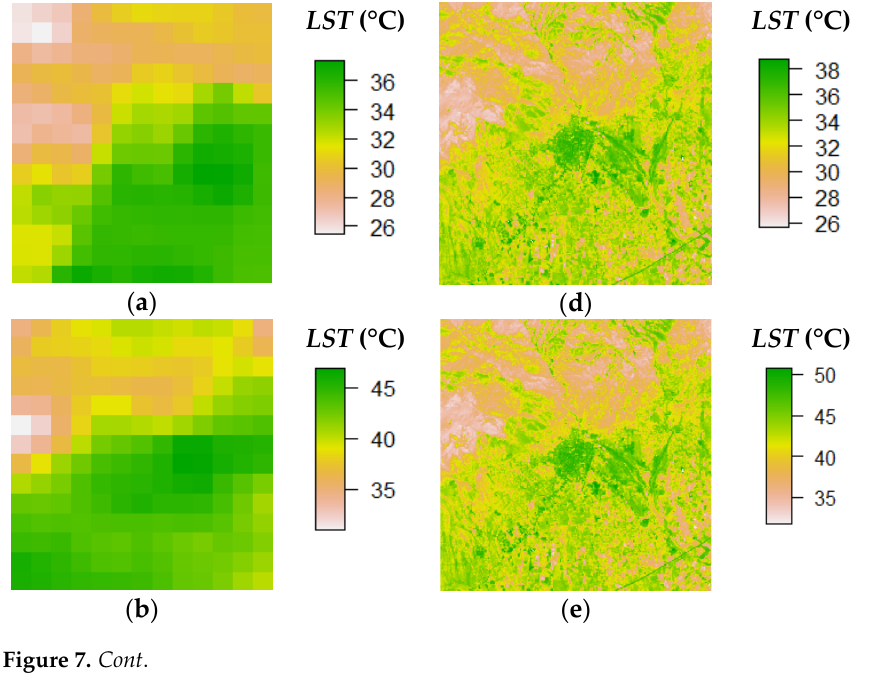
Figure 6. ( a ) The MODIS LST image (1000 m) on 30 July 2016 (11:35 UTC + 3). ( b ) The LST image (1000 m) on 30 July 2016 (22:28 UTC + 3). ( c ) The downscaled image (10 m) on 30 July 2016 (11:35 UTC + 3). (d) Downscaled image (10 m) on 30 July 2016 (22:28 UTC + 3). Table 8. The LST values in both city and suburbs at 1000 m and 10 m spatial resolution.